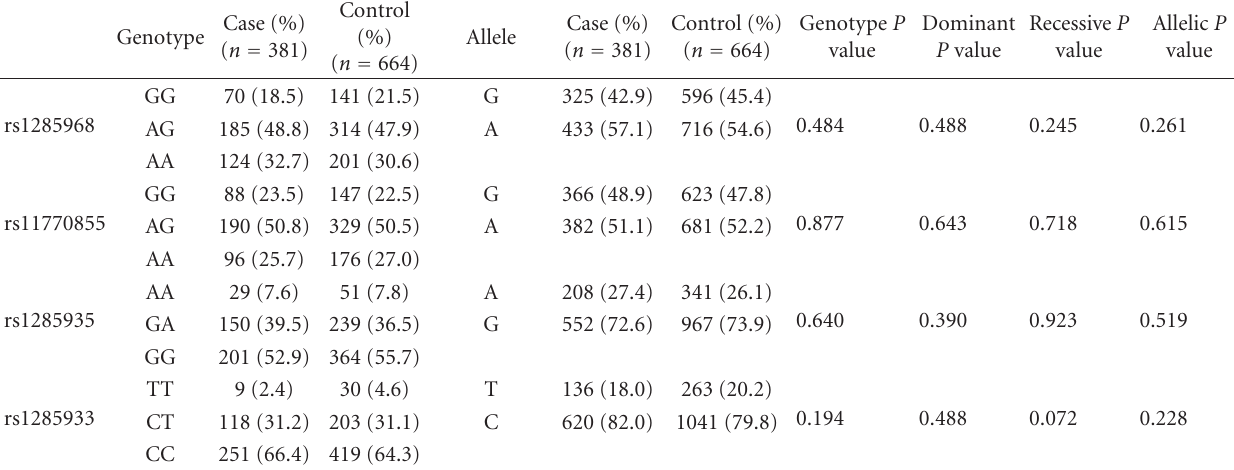
Table 2: Genotype and allele frequencies of the CLEC5A gene in controls and patients with Kawasaki disease. Case (%) Genotype ( n = 381)